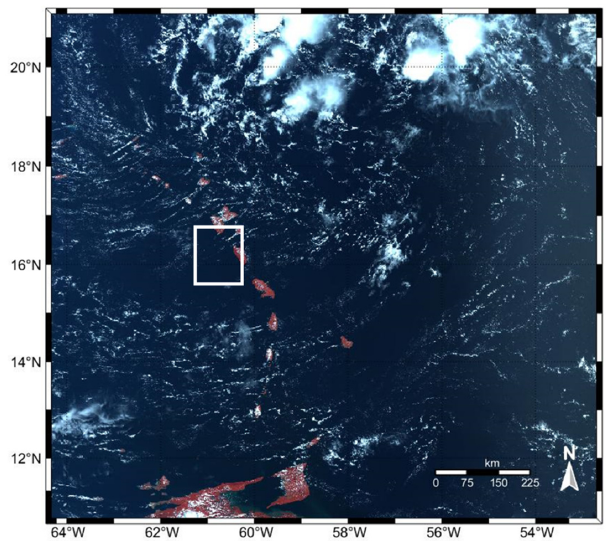
Figure 2. False color composite (NIR Green Blue bands) of the OLCI image acquired on 8 July 2017, 13:55 (UTC); the white square shows the regional study area in the west of Dominica.